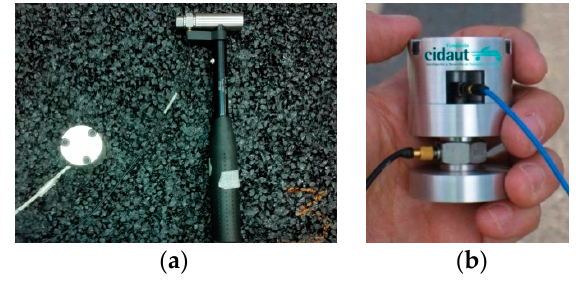
Figure 6. ( a ) Mechanical impedance setup. ( b ) Impedancimeter.